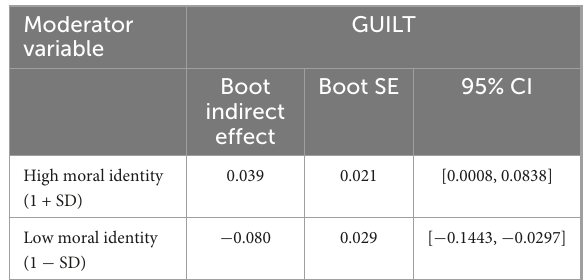
TABLE 6 Results of conditional indirect